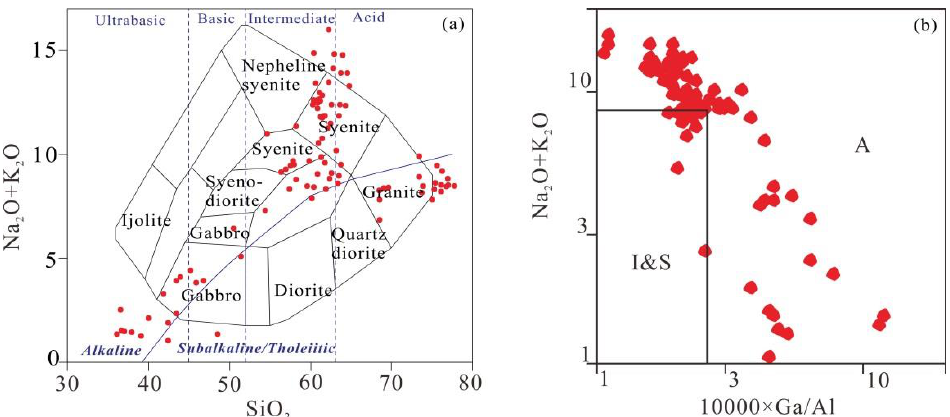
Figure 5. ( a ) Total alkali (K 2 O + Na 2 O) vs. silica (SiO 2 ) [68]; ( b ) total alkali (K 2 O + Na 2 O) vs. 10,000 × Ga / Al [69] (data from [19,20,38,41,44–46]).